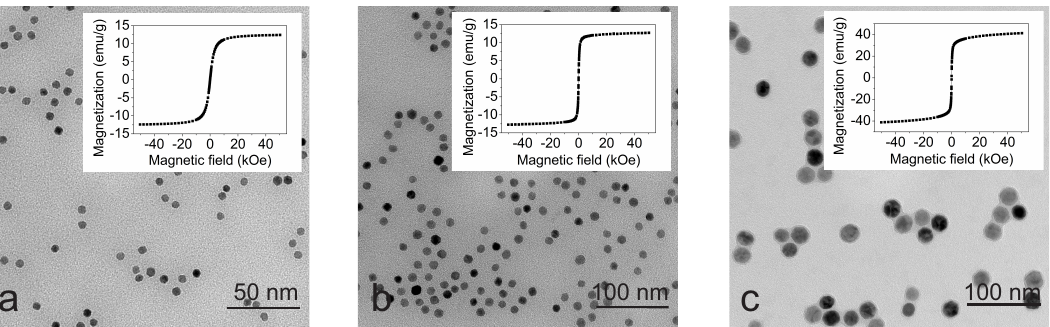
Figure 2. TEM images of ( a ) 5 nm, ( b ) 10 nm and ( c ) 20 nm MNPs as well as the respective magnetization curves shown in the inset plots are